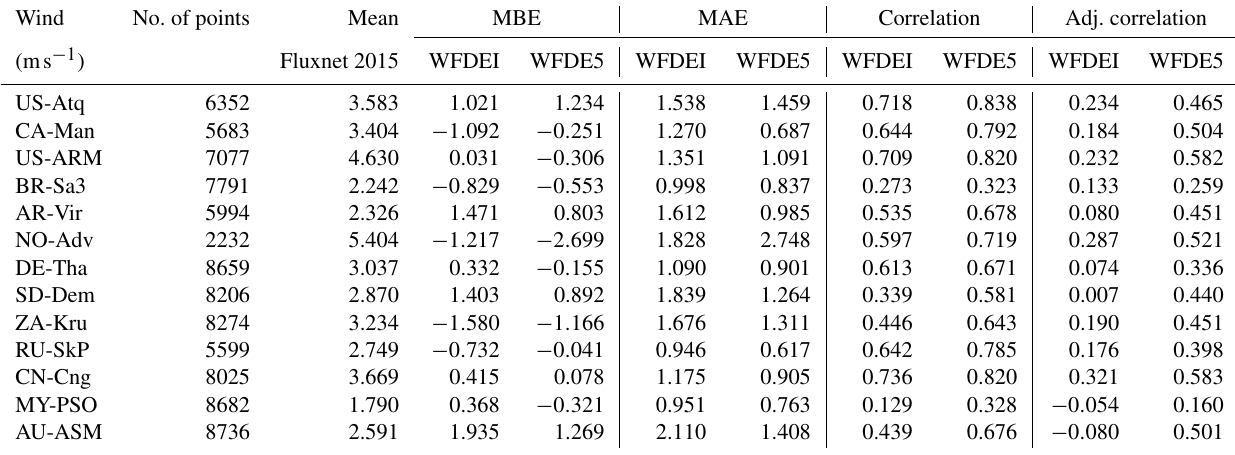
Table A12. Wind metrics for each FLUXNET2015 site: WFDEI versus FN2015 and WFDE5 versus FN2015 at 3-hourly time steps. Wind